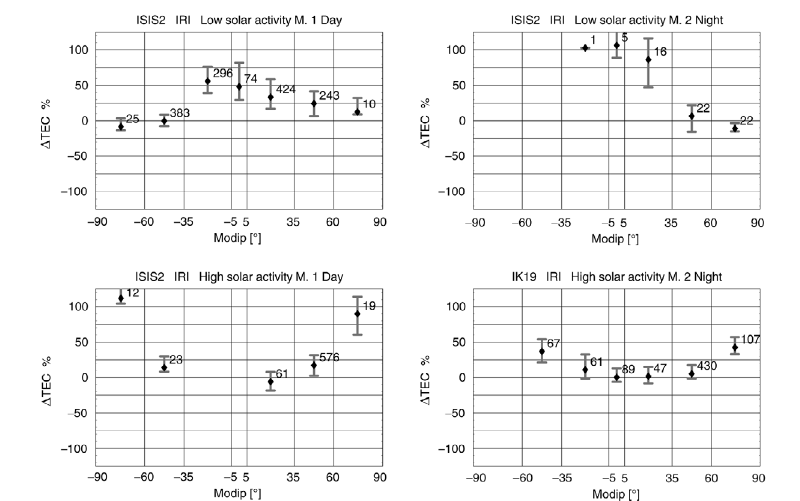
Fig. 4. Comparison of topside TEC, IRI model: percent difference for months groups 1 and 2. Numbers indi- cate the amount of data.